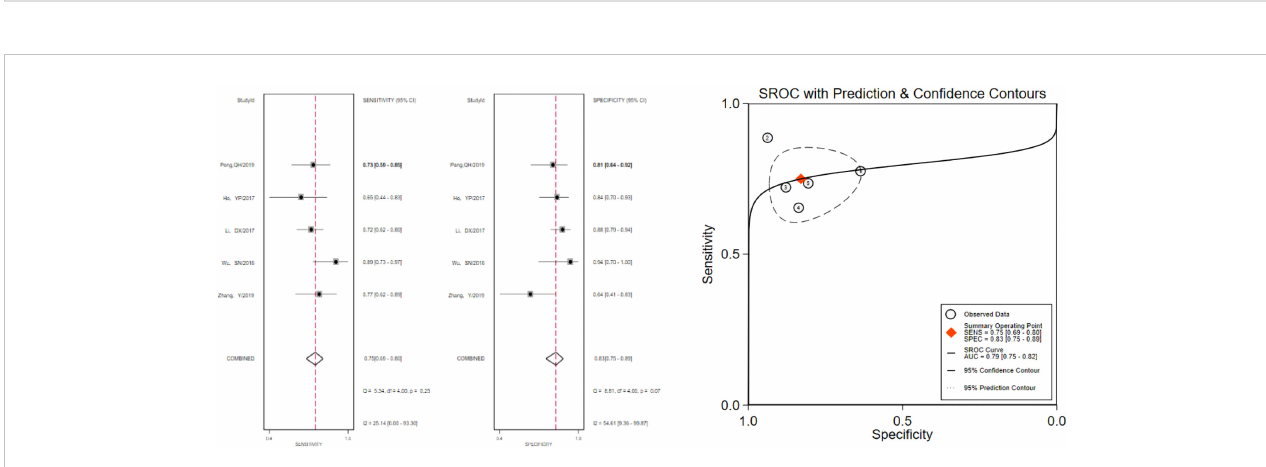
FIGURE 3 The sensitivity and speci fi city of the A VTIQ group in the diagnosis of thyroid nodules and the summary ROC (Summary ROC) curve of the A VTIQ group were analyzed. the AUC indicates the area under the